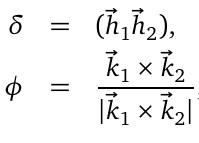
Figure 1: The distribution of ω positive (cyan) τ − helicity. The distribution is similar for all considered τ decay